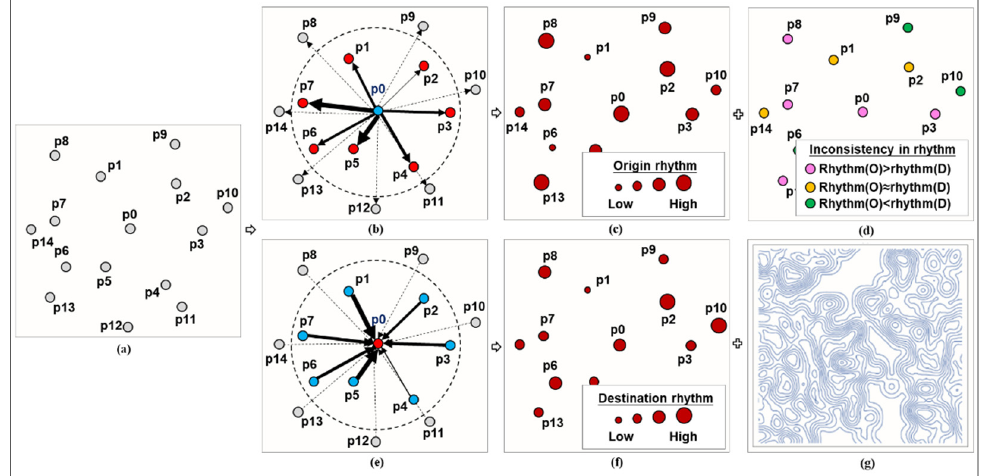
Figure 3. Rhythm analysis flow chart based on the docking stations of public bicycles. ( a ) spatial distribution of all public bicycle docking stations; ( b ) source stations; ( c ) origin rhythms; ( d ) inconsistency in rhythm; ( e ) sink stations; ( f ) destination rhythms; ( g ) rhythm contour.